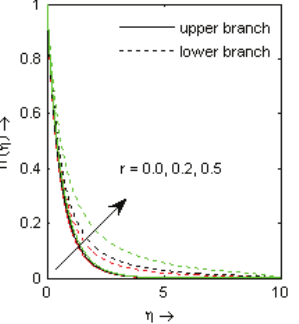
Figure 5. Dual temperature profiles h ( (cid:29) ) for various values of r with s